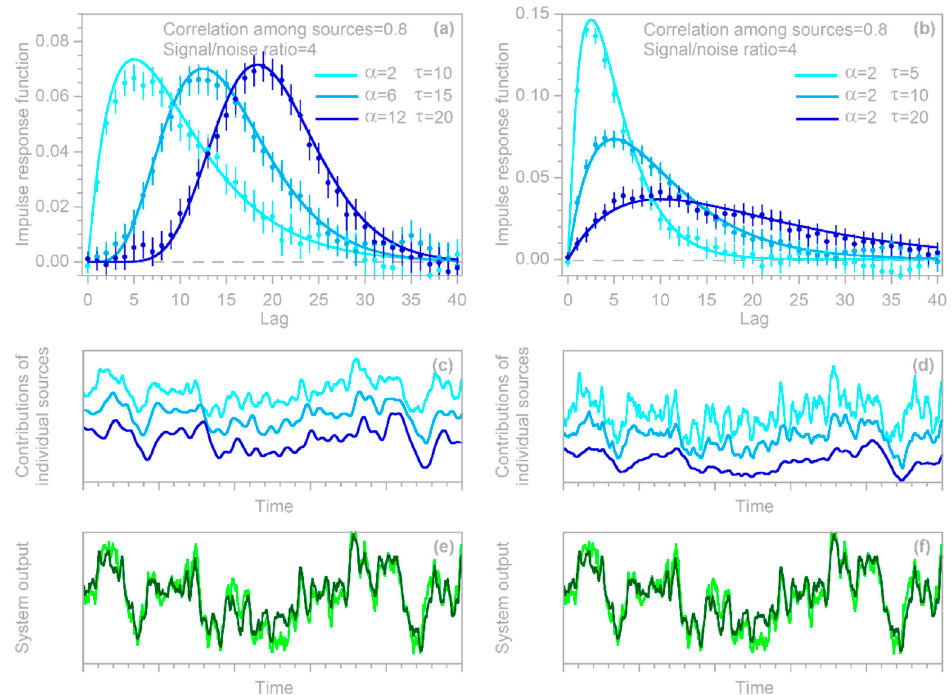
Figure 4. Benchmark test with demixing of impulse response functions from three correlated sources that are mixed together in a system output that is corrupted by ARMA noise. The left column ( a , c , e ) shows three sources convolved with kernels exhibiting roughly similar dispersion, but different lag times, and the right column ( b , d , f ) shows three sources convolved with kernels exhibiting different degrees of dispersion. The top panels ( a , b ) show the three sources’ benchmark convolution kernels (lines) and their impulse response functions calculated from the individual inputs and their combined output (points). Error bars indicate 1 standard error. The middle panels ( c , d ) show each of the three convolved sources’ contributions to the system output, with colors matching the corresponding convolution kernels and IRFs in the top panel, and with each line shifted vertically for clearer visualization. The bottom panels ( e , f ) compare the combined system output (the sum of the three curves shown in the middle panels, shown in dark green), compared to the ARMA noise-corrupted y j used as input to the IRF calculations (shown in light green). Values of α and τ in ( a , b ) are parameters of the gamma distributions used for the benchmark impulse responses. The middle and bottom panels show 500 time steps, equaling five percent of each time